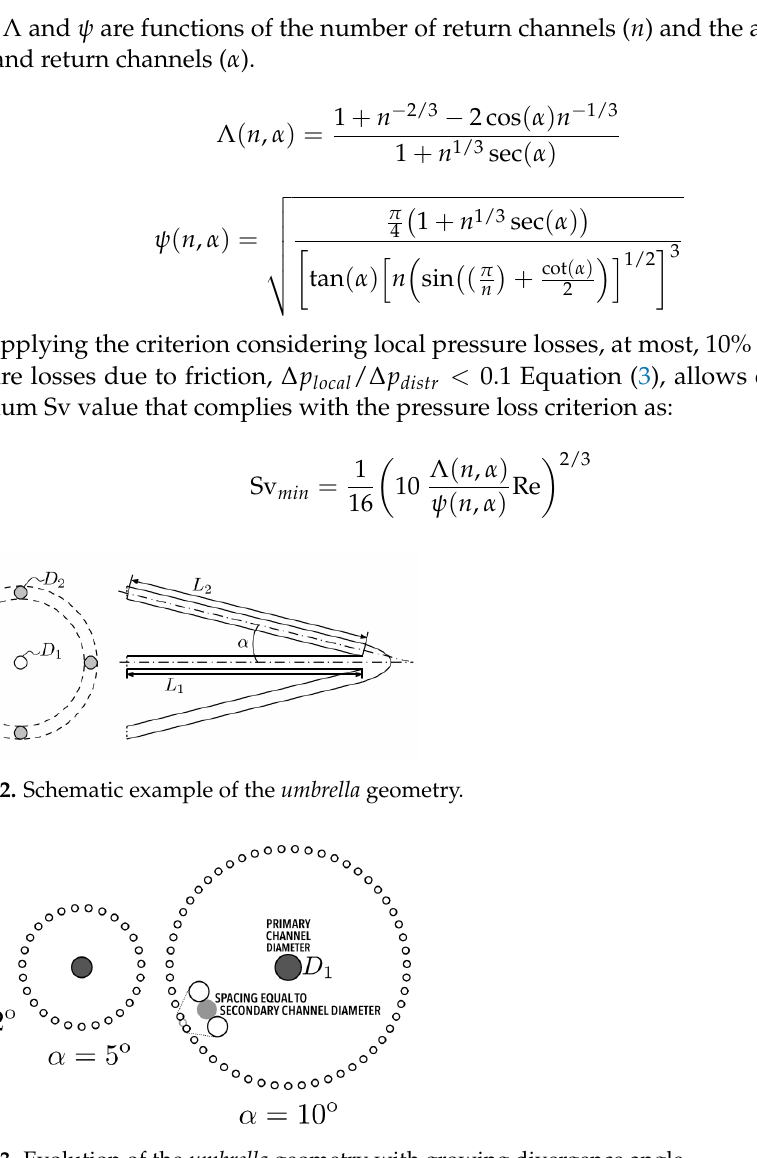
Figure 3. Evolution of the umbrella geometry with growing divergence